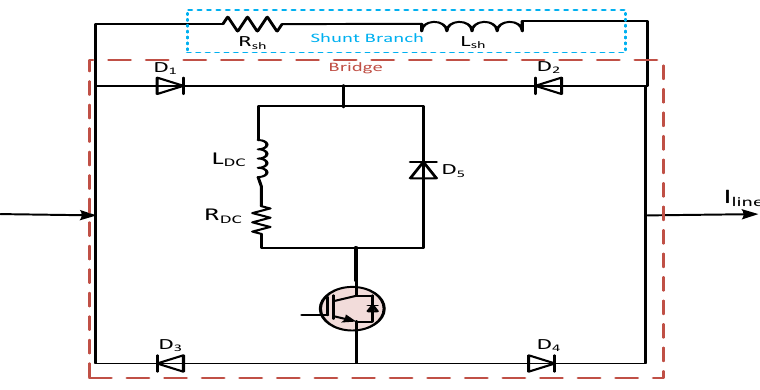
Figure 10. Bridge type fault current limiter.